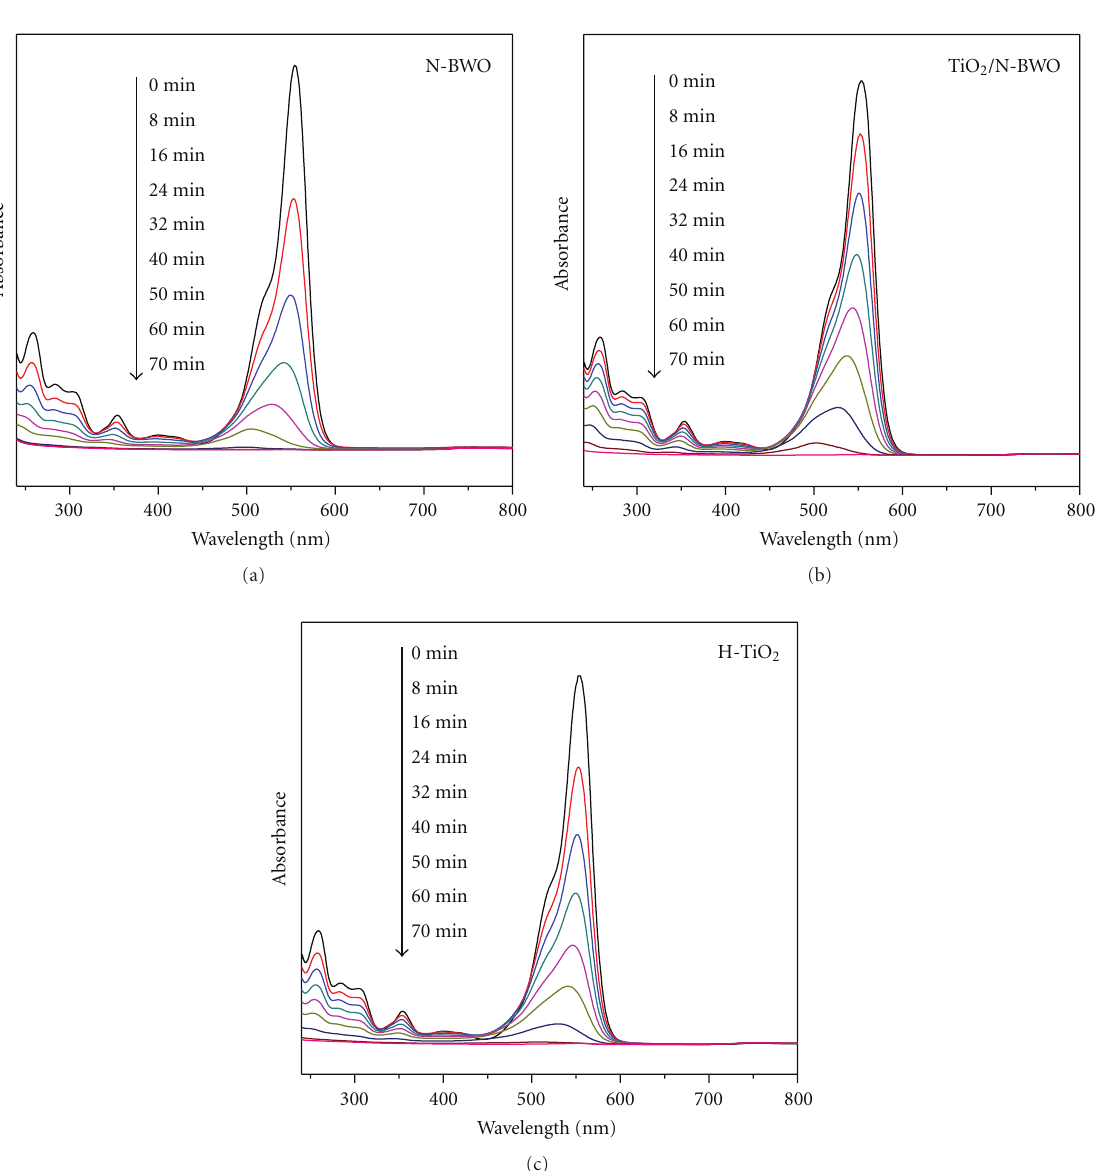
Figure 8: Temporal evolution of the spectral changes during the photodegradation of RhB over N-BWO, TiO 2 /N-BWO, and H-TiO 2 under ultraviolet light